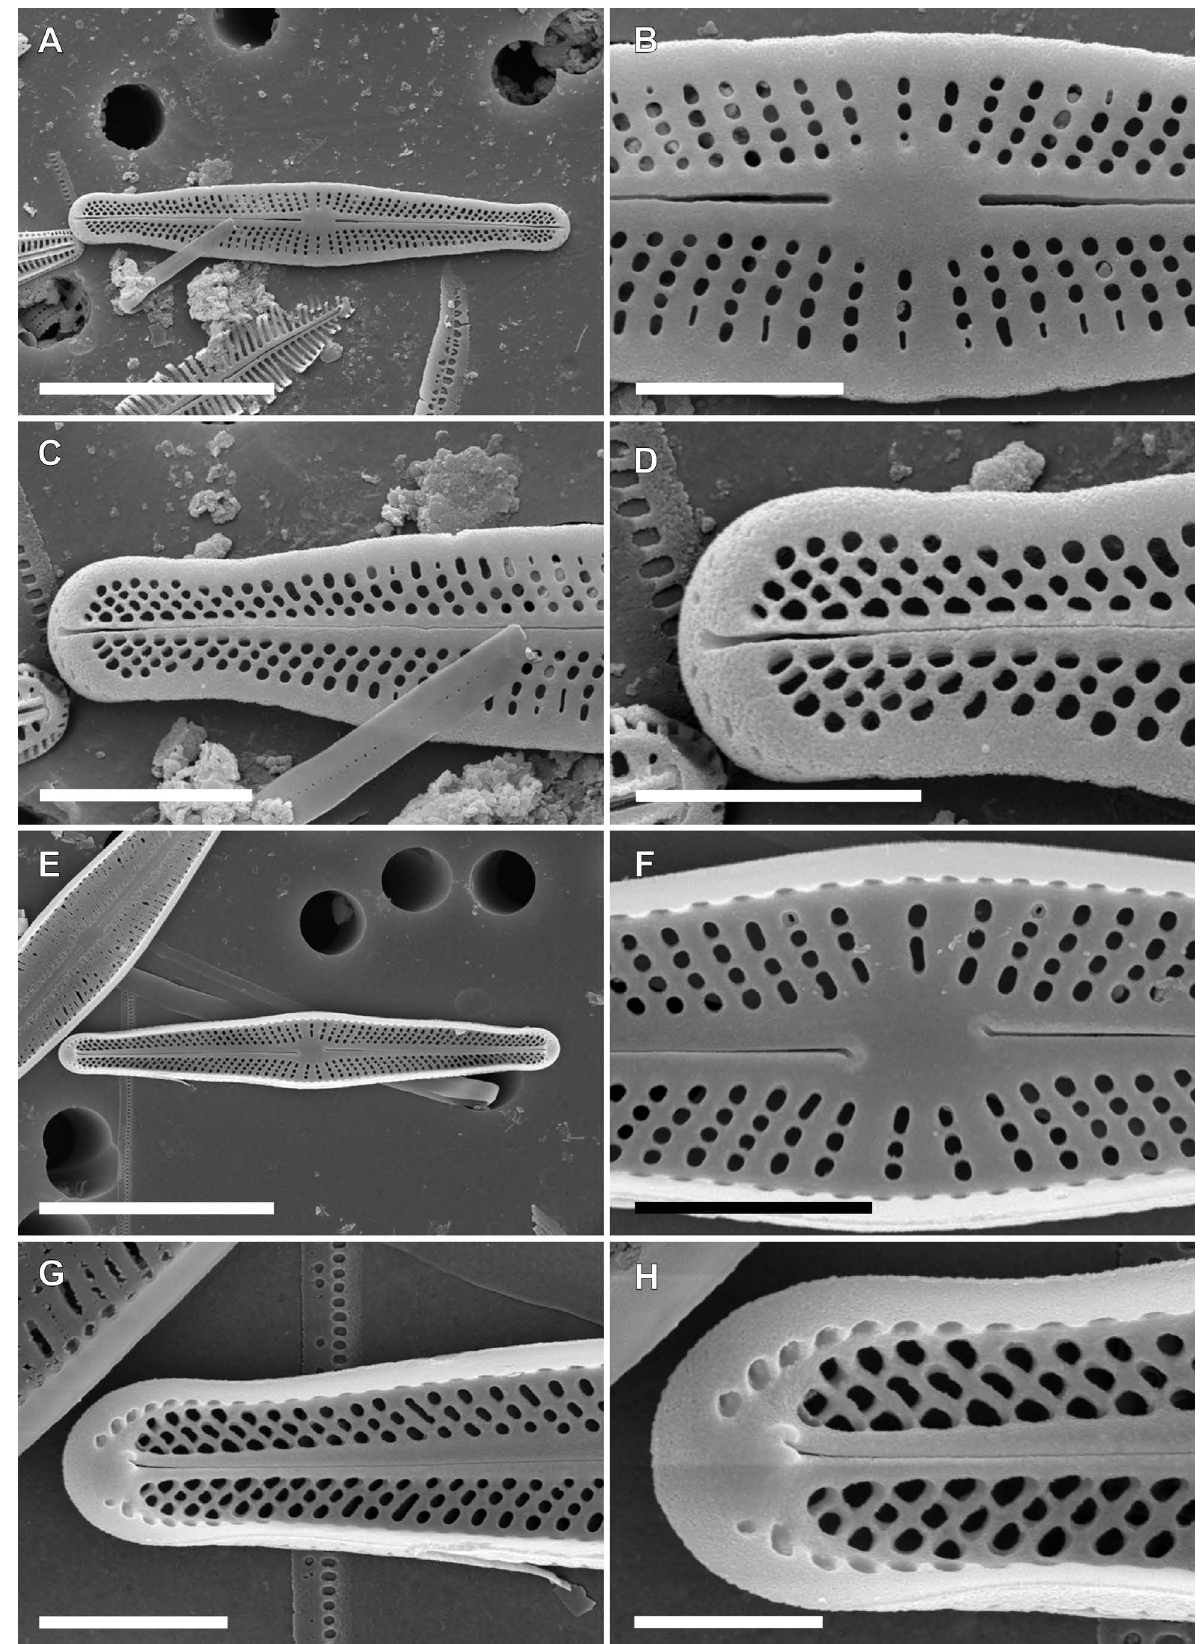
Figure 6. Achnanthidium dumlupinarii sp. nov., SEM micrographs. A . General external valve view of a raphe valve. B . Detail of the central area of a raphe valve showing the slit–like areolae in the margins. C , D . Details of apices. E . General internal valve view of a raphe valve. F . Details of central area. G , H . Details of apices. Scale bars 10 µm (A, E), 3 µm (D), 2 µm (B, C, F, G), 1 µm